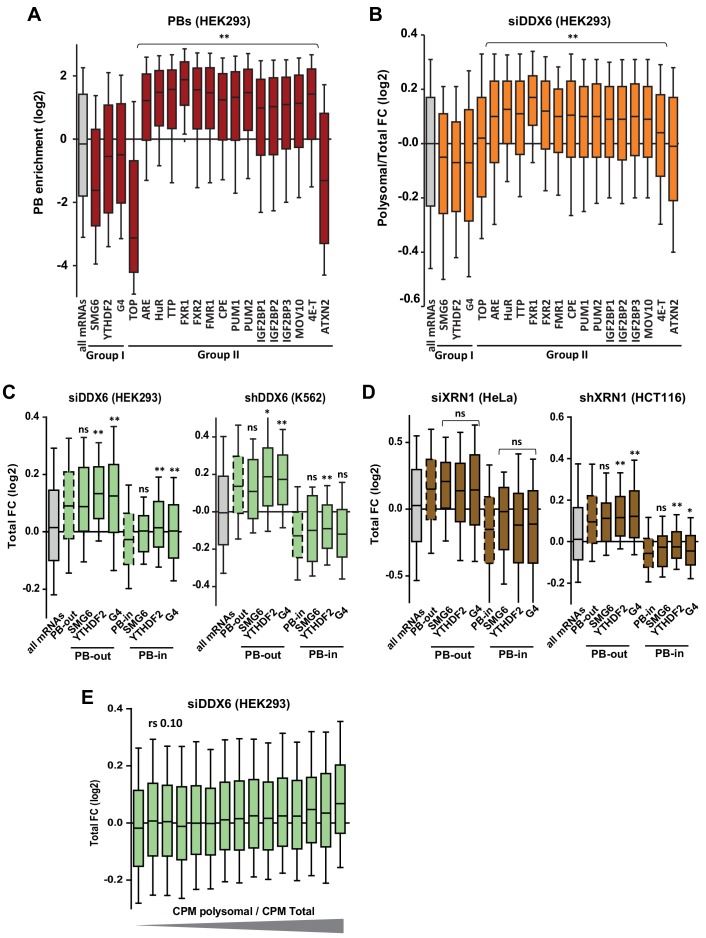
Targets of group I and II regulators (part II).(A) PB localization of the different mRNA subsets. Only the targets of group II factors were enriched in PBs, except ATXN2. Note also that SMG6 targets and TOP mRNAs were particularly excluded from PBs. (B) Sensitivity of the different mRNA subsets to DDX6 silencing in HEK293 in terms of translation rate(polysomal/total mRNA ratio). Only the targets of group II factors were translationally derepressed, except ATXN2. Two-tail Mann-Whitney test was performed with respect to all mRNAs. **, p<0.0001. (C, D) The targets of group I regulators were stabilized after DDX6 (C) and XRN1 (D) silencing mostly like other PB-excluded mRNAs. The same analysis as in Figure 5—figure supplement 1B and C was conducted separately on PB-excluded (PB-out) and PB-enriched (PB-in) mRNAs. The distribution of all mRNAs (in gray), all PB-out and all PB-in mRNAs (dashed boxes) are shown for comparison. Two-tail Mann-Whitney test was performed with respect to cognate PB-out or PB-in mRNAs. **, p<0.0001; *, p=0.006 for (C) and 0.02 for (D); ns, non-significant. (E) DDX6-dependent mRNA decay does not correlate with polysome engagement. The fraction of mRNAs in polysomes (polysomal/total cpm) was calculated using the RNA-Seq data from control HEK293 cells. Transcripts were subdivided into 15 bins (1000 transcripts each) of increasing value. The boxplot represents their fold-change (FC) distribution in total RNA following DDX6 silencing.